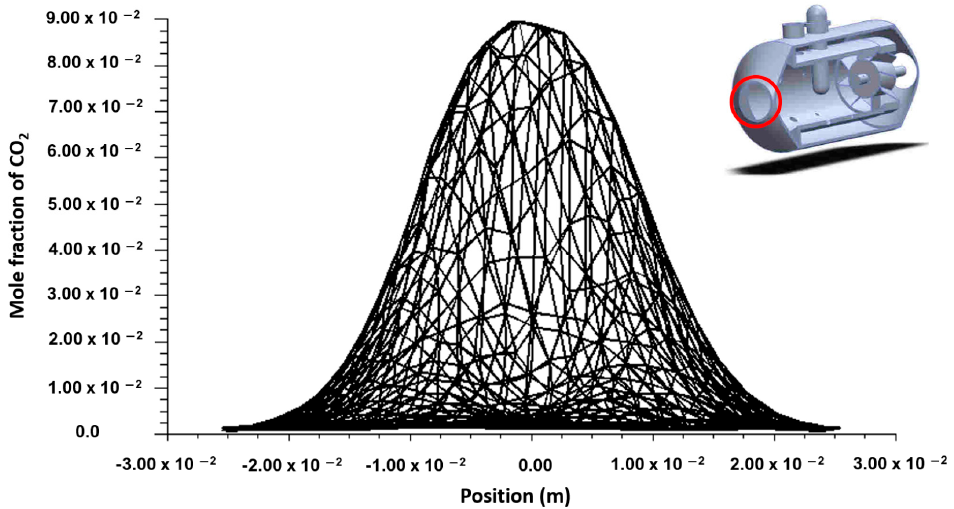
Figure 13. Mole fraction variation of CO 2 at the outlet of the combustion chamber on the y -axis.